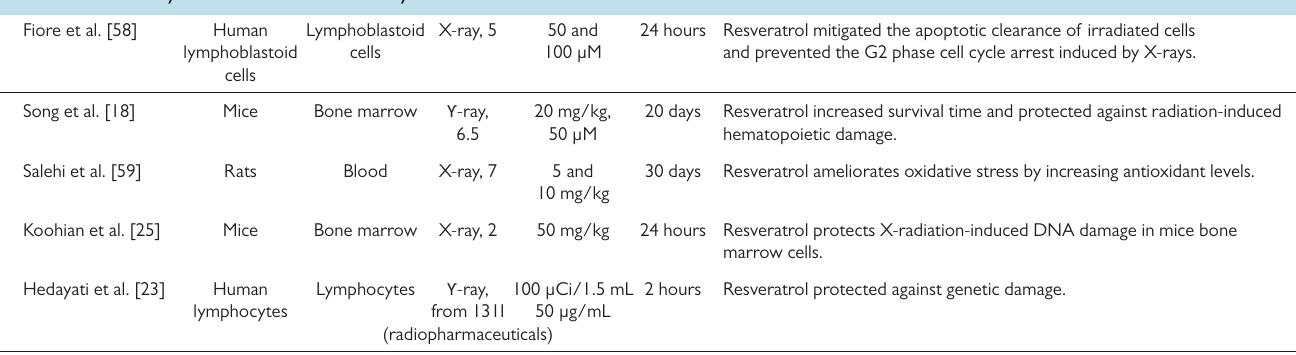
Table 1. Summary of articles included in the systematic review Fiore et al.